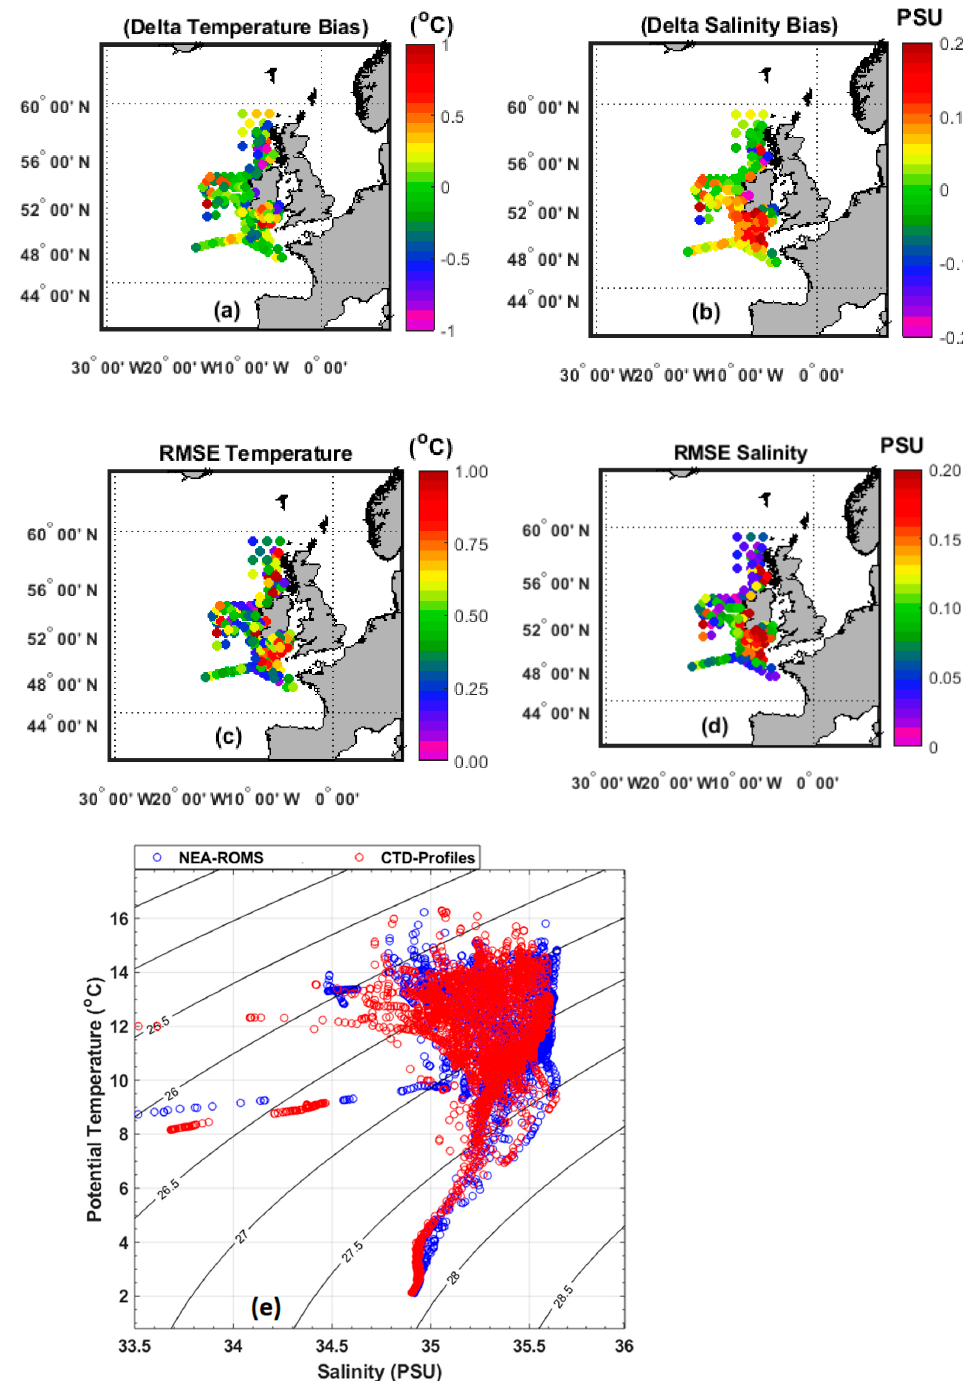
Figure 8. The bias and RMSE between NEA_ROMS and 223 CTD profiles locations in 2017. ( a ) Bias temperature, ( b ) bias salinity, ( c ) RMSE temperature, ( d ) RMSE salinity, ( e ) T-S diagram.